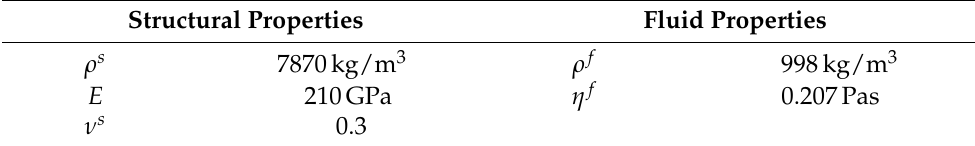
Table 1. Structural and fluid properties.